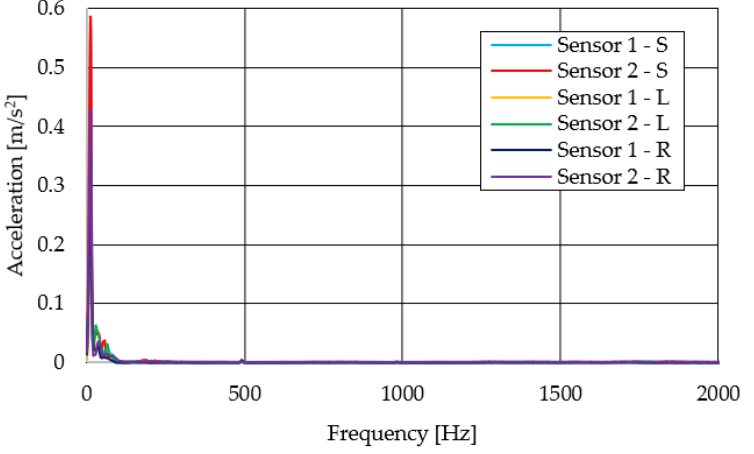
Figure 28. Comparison of the frequency waveforms in the z -axis.